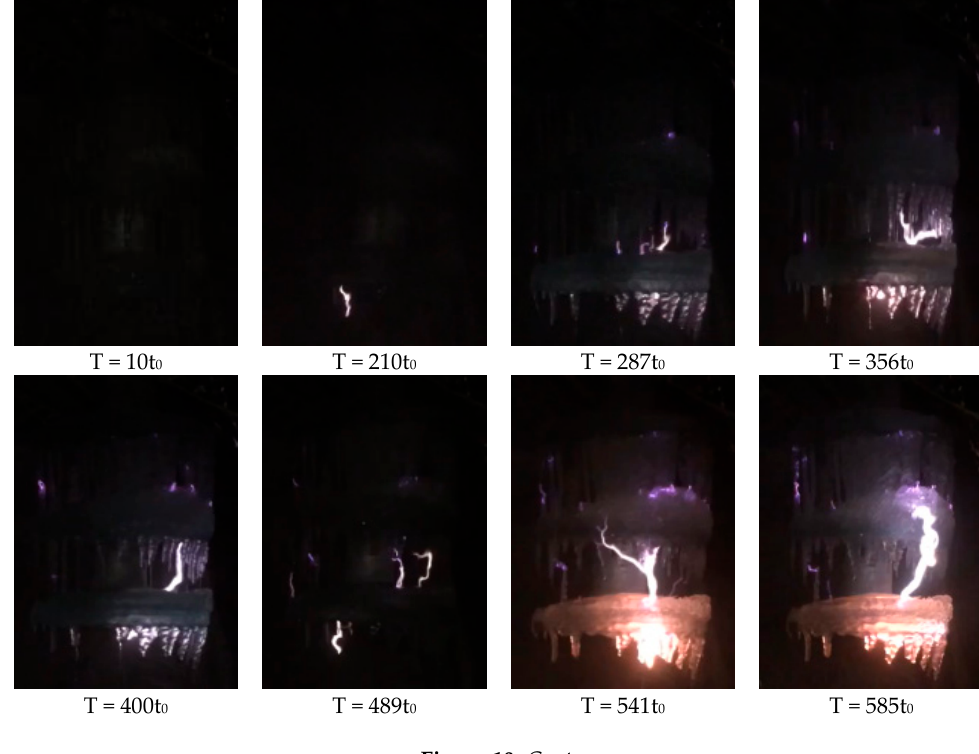
Table 3. Key technical parameter of